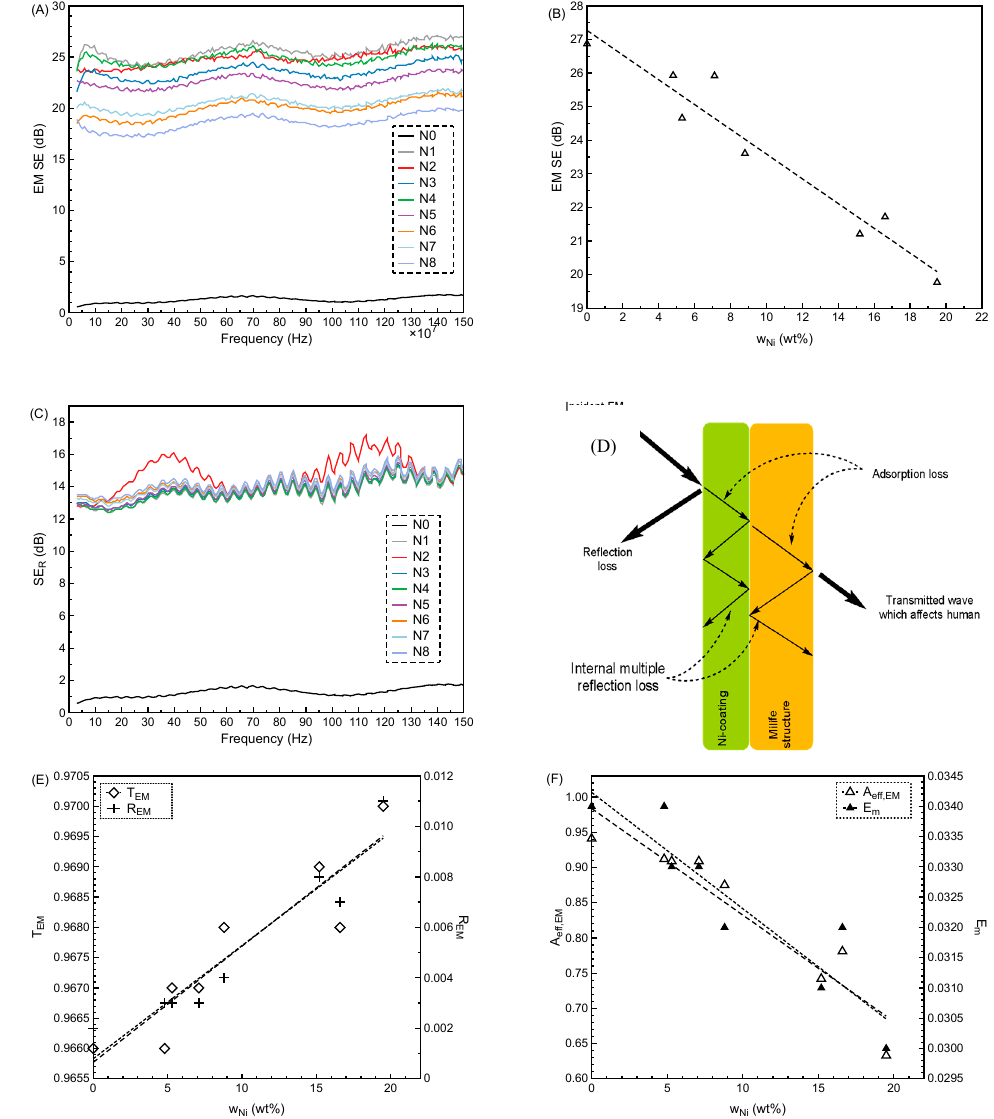
Figure 8. EMI results of Cu / Ni-coated Milife fabric ( A ) EM SE curves; ( B ) SE R curves; ( C ) scheme of the EM in the fabric; ( D ) relationship between w Ni and EM SE; ( E ) relationship between w Ni and both T EM and R EM ; ( F ) relationship between w Ni and both A eff,EM and E m,EM . Table 2. Results of EMI evaluation at 1.5GHz frequency.